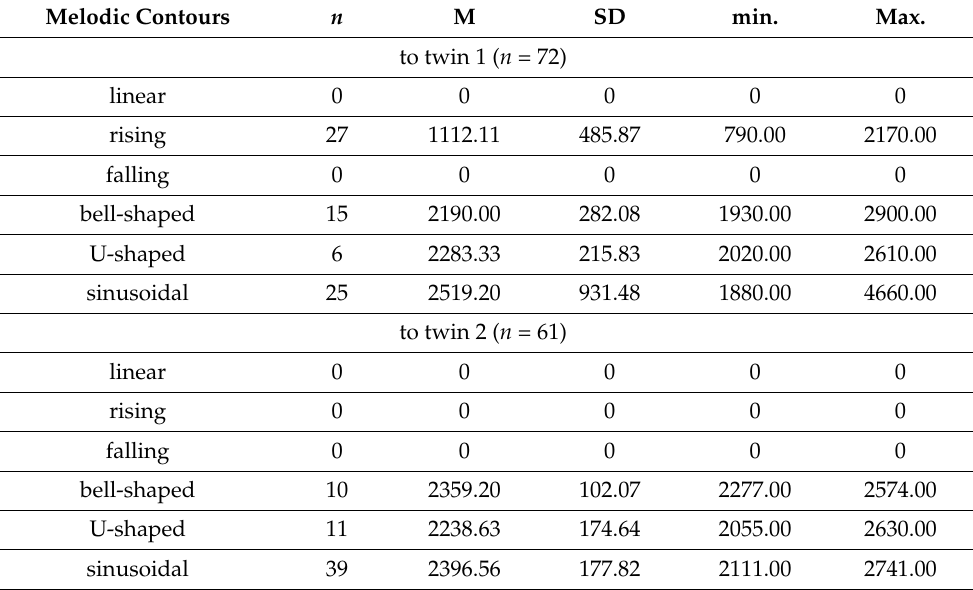
Table 4. Descriptive analysis of melodic contour lengths (ms) in humming to twin 1 and to twin